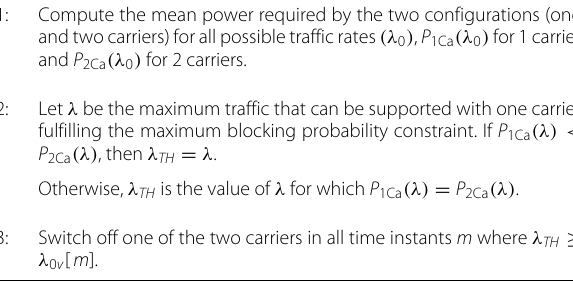
Table 2 Threshold computation for switching on/off